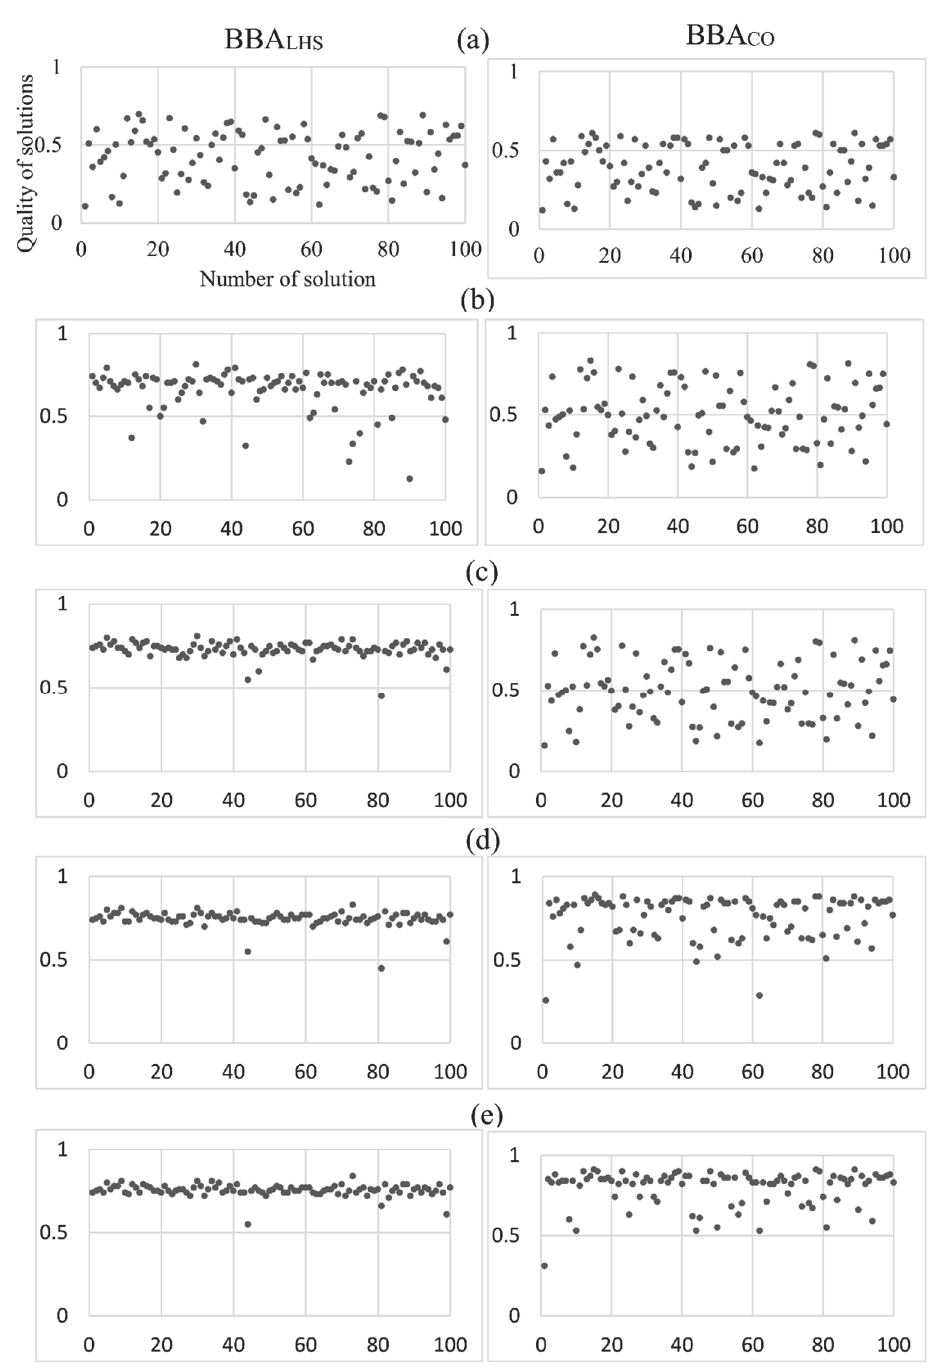
Figure 6. Diversity of solutions in ( a ) first generation, ( b ) generation 20, ( c ) generation 50, ( d ) genera- tion 80 and ( e ) generation 100, using BBA LHS (left) and BBA CO (right) for Reuters